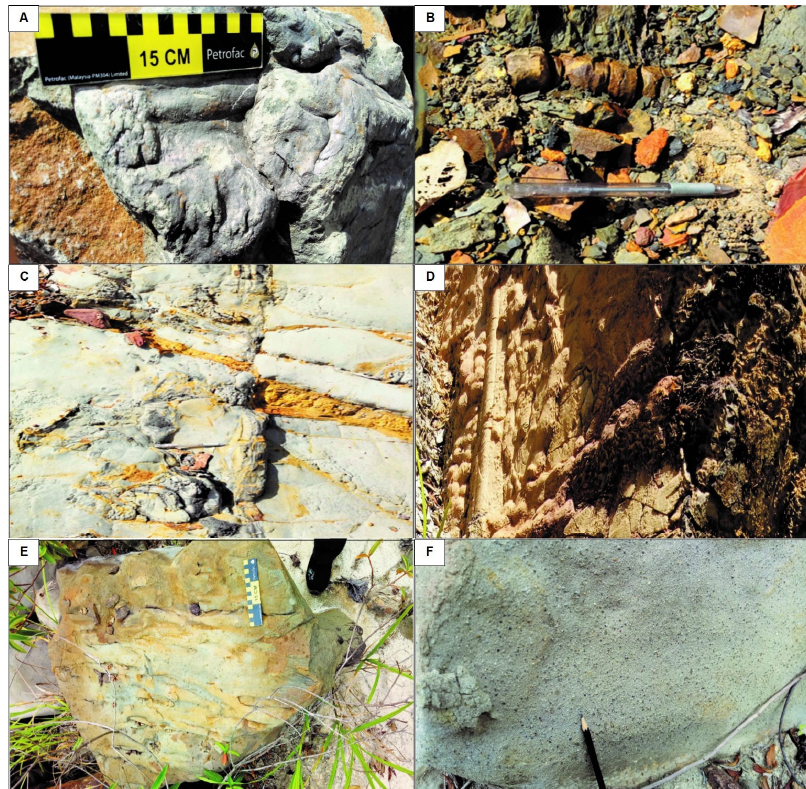
Figure 3. Examples of sedimentary structures in the Crocker Formation. ( a ) Flame structure found in L1. ( b ) Complete Bouma sequence from Ta to Tf found in L3. ( c ) Rip-up mud clasts in L2. ( d ) Cruziana sp. of trace fossils in L2.